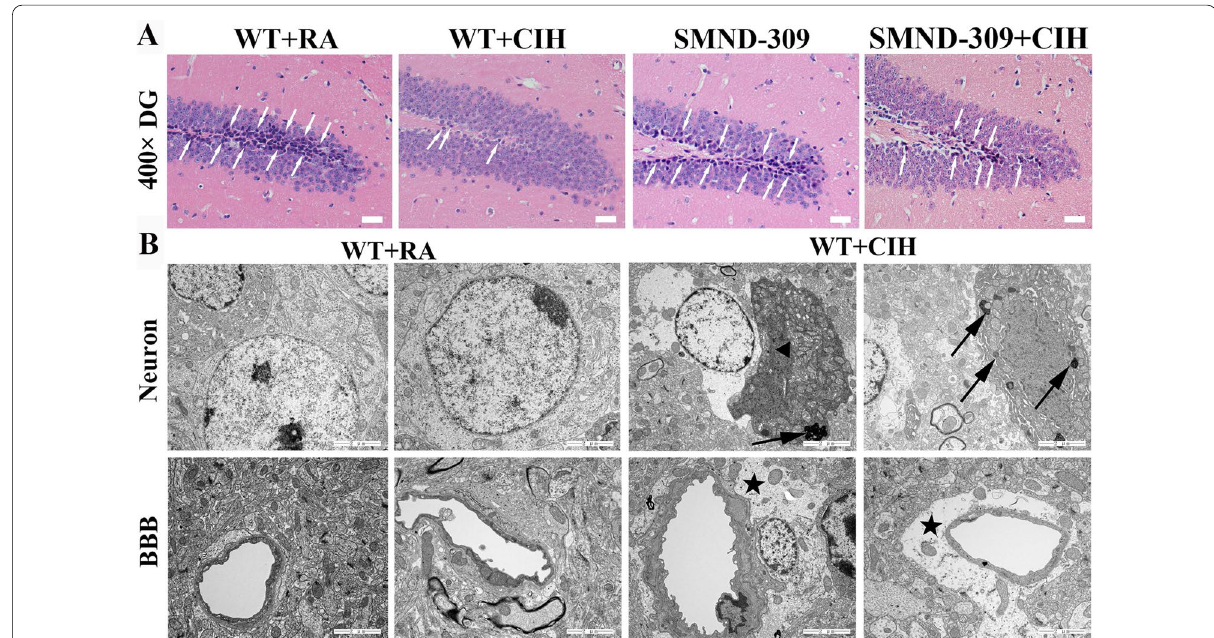
CIH group, NBs were hardly observed (White + . B The TEM results of the hippocampus. Neurons of the × . All ×